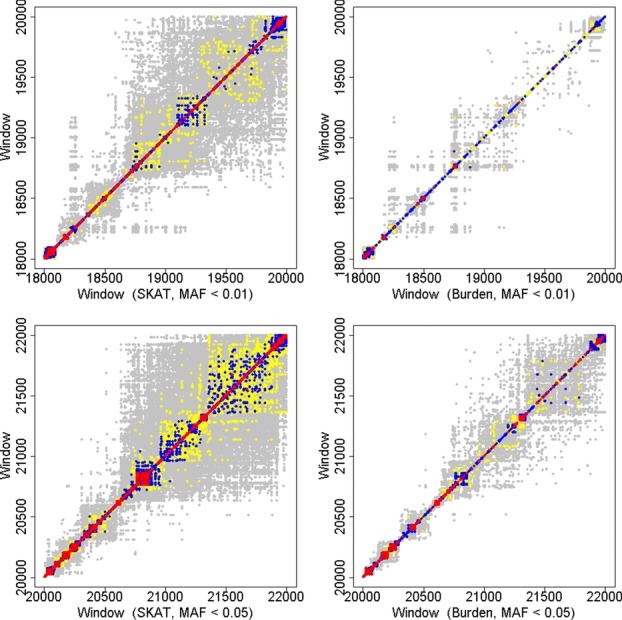
Correlations between 2,000 adjacent window-based tests statistics for SKAT and burden tests and for two different MAF thresholds. Because windows were defined to contain the same number of rare variants, the boundaries of the windows vary with MAF. Regions have been aligned so that the genomic region captured in the bottom row is contained within the genomic region at the top. The axes are the window numbers, counted from the 5' end of chromosome 3. Left column: SKAT tests. Right column: burden tests. Top row: MAF threshold = 0.01; bottom row: MAF threshold = 0.05. Gray: correlation > 0.1; yellow: correlation > 0.35; blue: correlation > 0.5; red: correlation > 0.75.